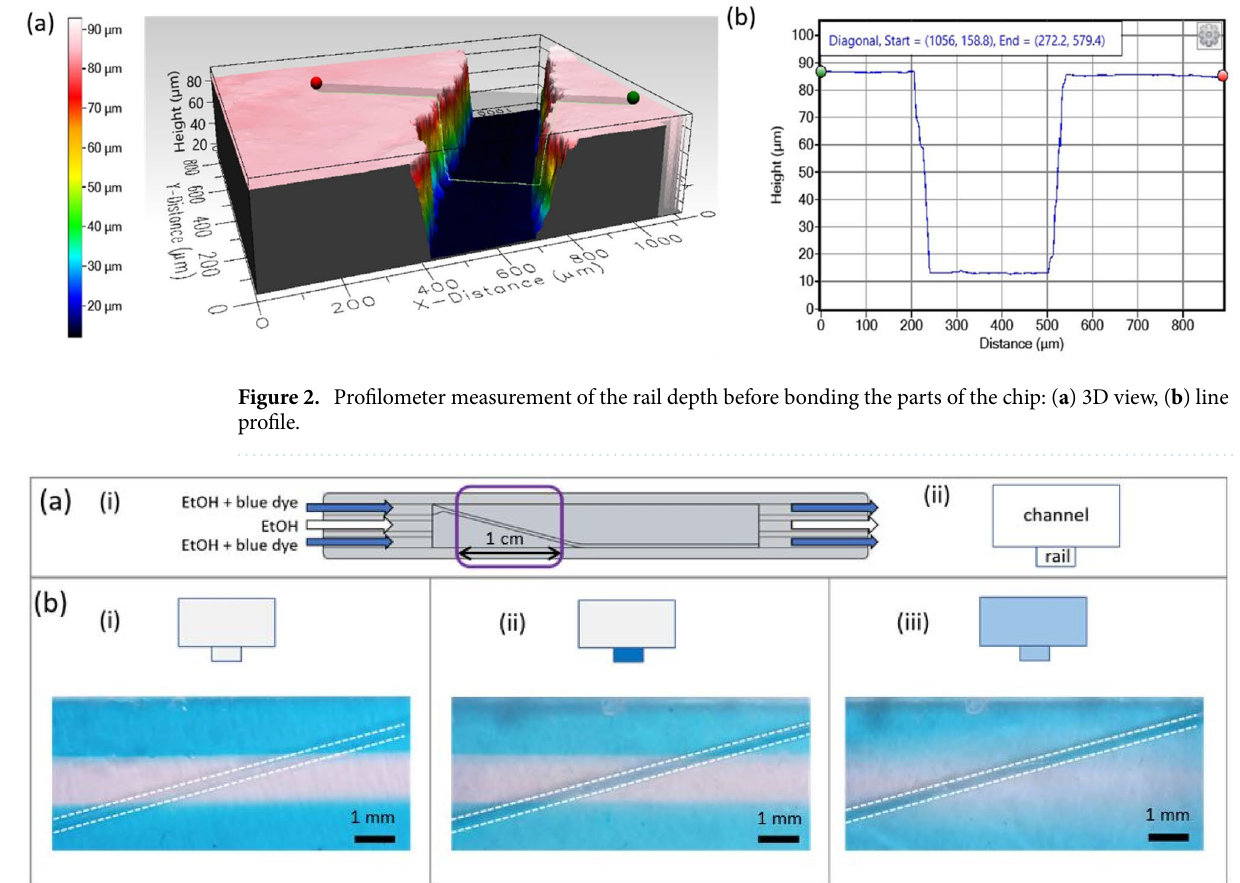
Figure 3. ( a ) Scheme of the experiment: (i) top view of the chip, (ii) cross section of the chip. ( b ) Three regimes observed for a rail at an angle of 15°, scale bar 1 The bottom part of the chip is 2 mm thick and has a groove (rail) milled on its surface. At the beginning of the rail there is a groove area in the shape of a triangle to facilitate entrapment of the particles introduced with the liquid during the experiment. The width of the rail is 300 µm and the depth of the rail is 45 to 310 µm, depending on the chip design. The depth of the rail was determined by a profilometer (Filmetrics Profilm 3D). Measure- ments were performed at five different positions for each rail (Fig. 2) before bonding the chip. The same method was applied to measure the roughness, R g , of the bottom surface of the chip and the rail. After testing different angles of rails: 0°, 5°, 10°, 15°; a zig-zag chip was designed and fabricated (Fig. 1d). The zig-zag chip was designed for on-chip LbL coating of particles and is built, similarly to the previous chips, from three layers, but it is longer (the top layer has dimensions 6 mm × 20 cm, and the middle layer has a 4 mm wide and 18 cm long channel) and its rail is built of 0° and 5° rails connected together in the shape of a zig-zag. The zig-zag chip can therefore accommodate four rail segments at 5° with respect to the channel direction (see Fig. 1d). As an example of a zig- zag chip, an image of a PMMA chip with zig-zag step channel is shown in Fig. 1S. Ethanol was chosen as carrier liquid to study the behavior of the liquid flow in the chip for multiple reasons, with the most important one that it is an excellent solvent for many chemicals. Moreover, it wets PMMA which ensures easy removal of gas bubbles and prevents particles to stick to the surface. Ethanol was introduced to the chip through the three inlets. The middle stream was pure while the adja- cent streams were colored with blue dye to visualize the flow, see Fig. 3a. The flow rate of all three liquids was controlled with a syringe pump. The liquids were always introduced at the same flow rate, ranging from 20 to 240 mL h −1 with corresponding linear liquid velocities of 4.2 to 50 mm s −1 . Note that these values refer to aver- age liquid velocities in the chip. The liquid velocity is maximal at the central part of the flow and decreases to zero at the boundary. Therefore, at the level of particles moving near the bottom of the chip the fluid velocity is substantially smaller than the average value. The actual fluid velocities at the level of particles are estimated below in “Methods”, “Fluid velocity profile”. When performing the experiments, three types of behavior of liquid flow were observed, further referred to as regimes 1, 2 and 3, see Fig. 3b. Regime 1. Three clear stripes in blue-transparent-blue co-flowing liquids are observed. The liquid in the entire area of the middle stream is transparent. This means that (transparent) ethanol is in the rail and in the channel